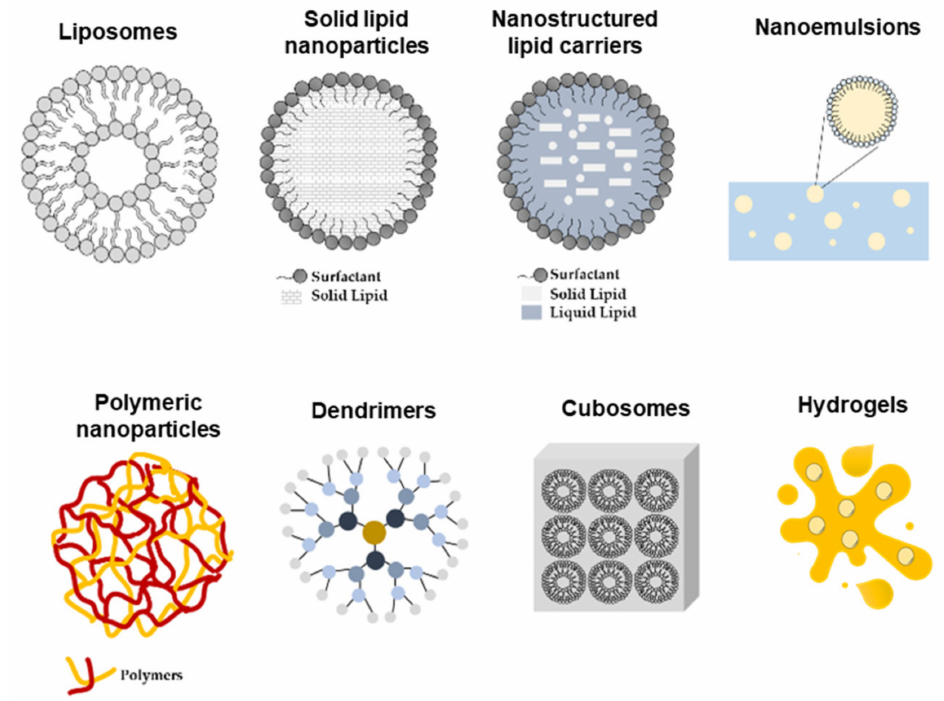
Figure 4. Schematic representation of nano-delivery systems used for topical skin